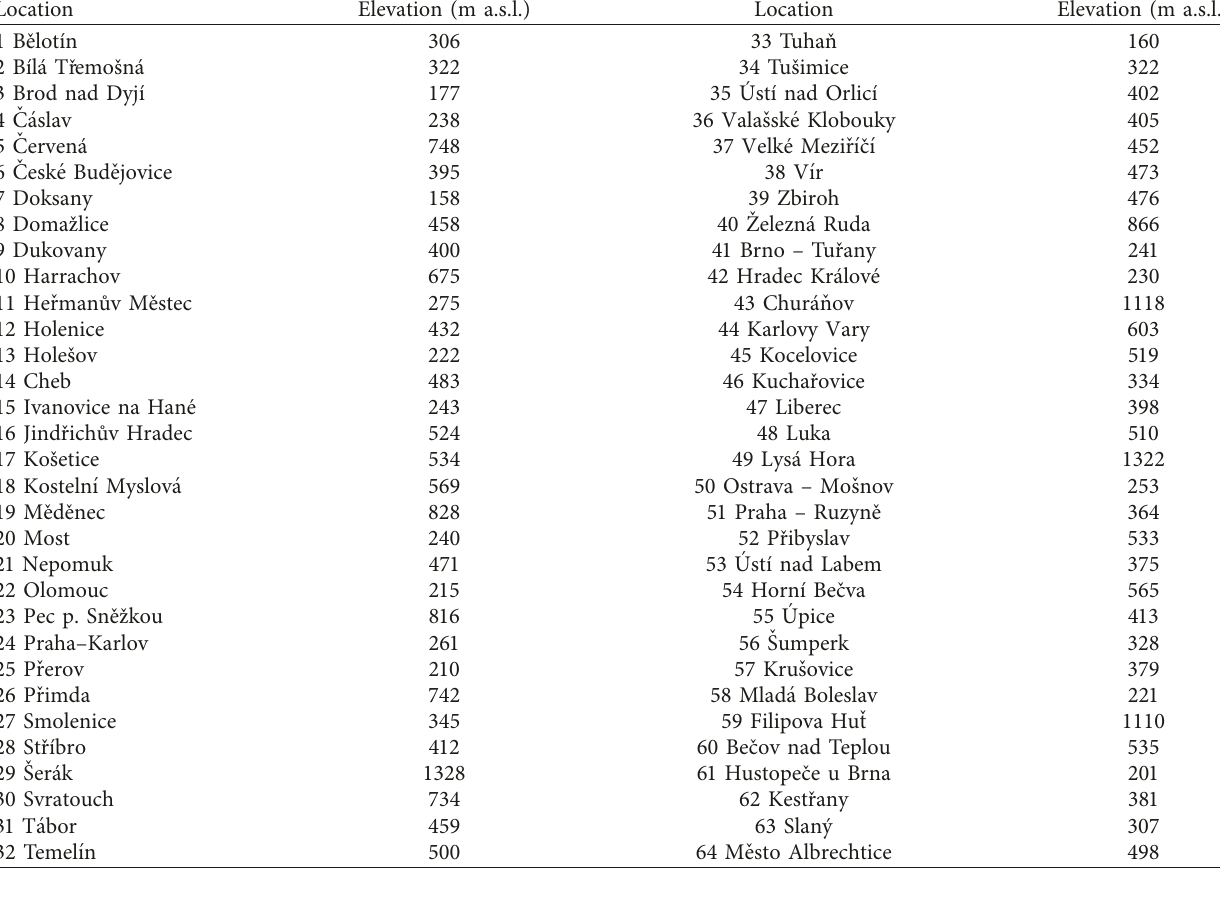
Table 1: List of applied weather data.